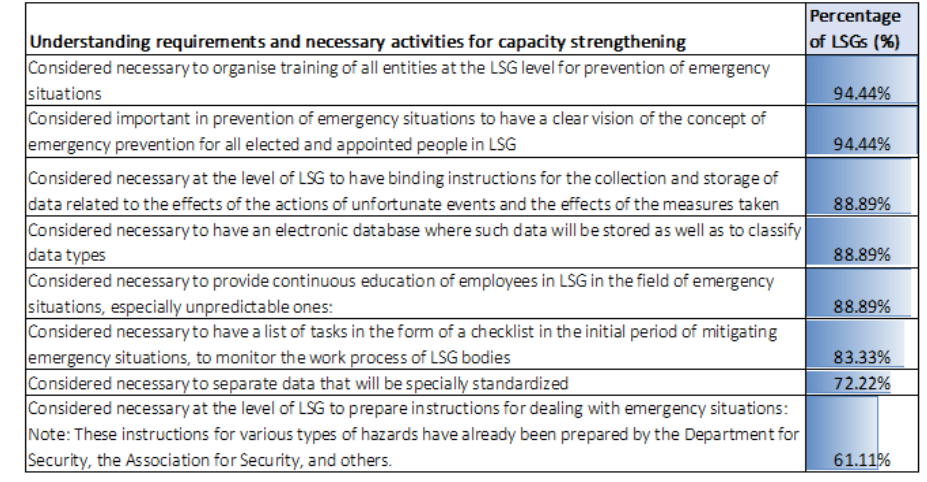
Table 5: Understanding Requirements and Necessary Activities for Capacity